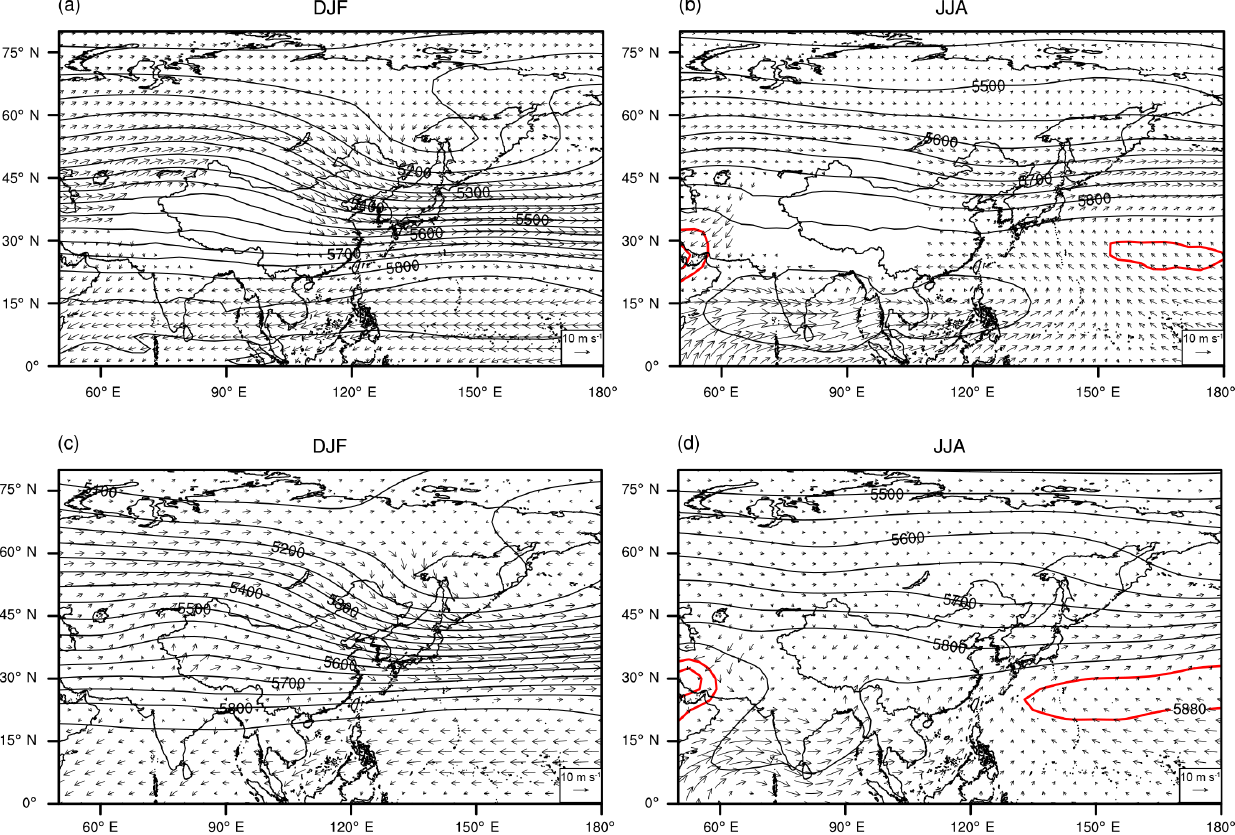
Figure 5. Comparisons between (a, b) the simulated and (c, d) reanalysis winter and summer geopotential height at 500hPa (contour; units: geopotential meters, gpm) and wind at 850hPa (vector; units: ms − 1 ), with the blank places in (a) and (b) are due to the influence of the Tibetan Plateau. Model results are from the group of CLI, and reanalysis data are from NCEP.